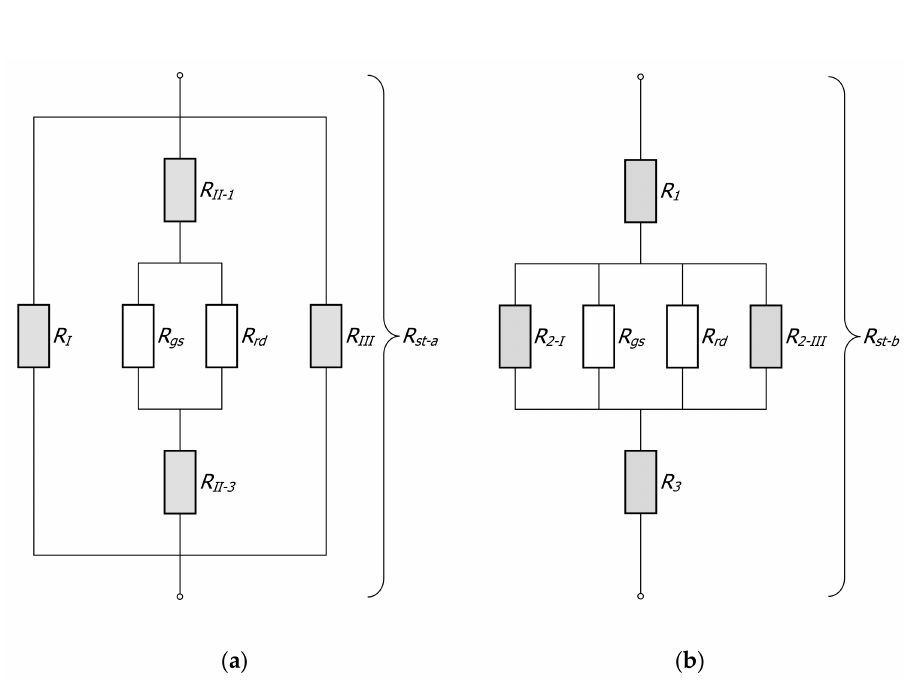
Figure 4. Thermal resistance networks of a rectangular section: ( a ) network for resistance R st-a and ( b ) network for resistance R st-b